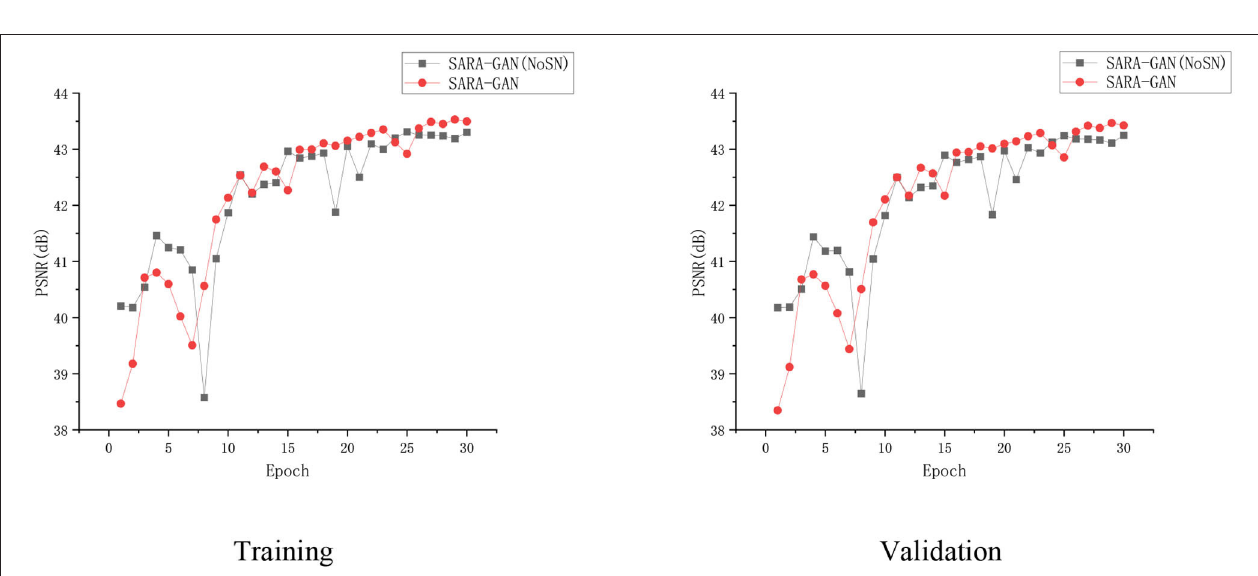
FIGURE 7 | The visual influence of self-attention mechanism on the reconstructed image. Proposed RASA-GAN (PSNR: 33.5931) and Proposed (NoSA) RA-GAN (PSNR: 32.9152).